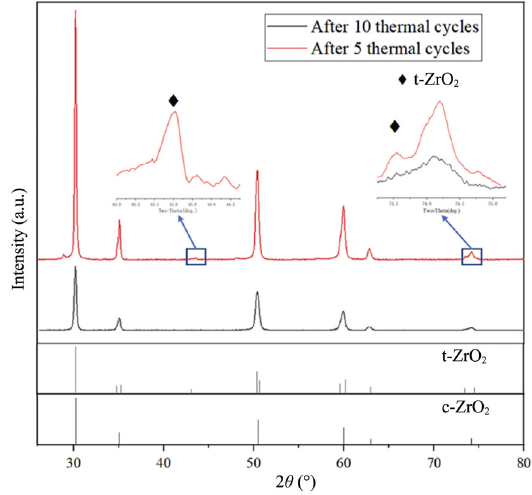
Fig. 9 XRD patterns of Al 2 O 3 –YSZ coatings after 5 and 10 thermal